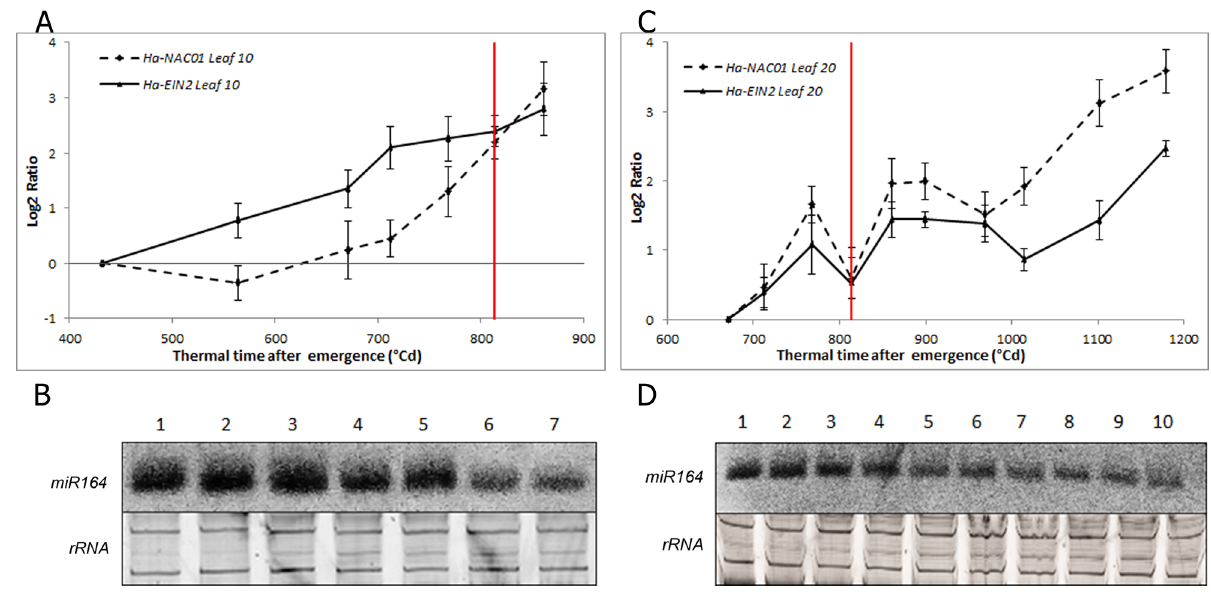
Figure 5. Ha-EIN2,Ha-NAC01 and miR164 expression profiles. (A) and (C) Transcript levels of Ha-EIN2 and Ha-NAC01 in relation to the first sampling point, using Ha-EF1 a as RG in leaf 10 and 20 respectively. The red line indicates anthesis time. (B) and (D) Northern blot analysis of miR164 levels in leaf 10 and 20, RNA from leaves 10 and 20 with an accumulation of degree days ( u Cd) between 432 to 861 (B: lanes 1–7) and 670 to 1180 (D:1–10), respectively, was blotted to nylon membrane and hybridized to radioactively labelled sunflower microRNA164 probe. rRNA bands stained with ethidium bromide are shown as loading control. Error bars correspond to standard errors.